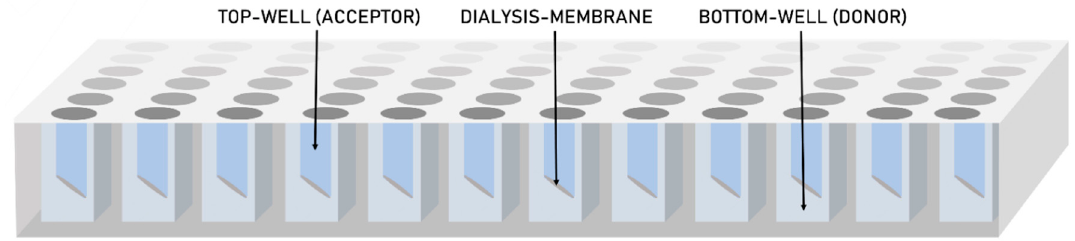
Figure 1. A schematic representation of the 96-well two-compartment microtiter plate.